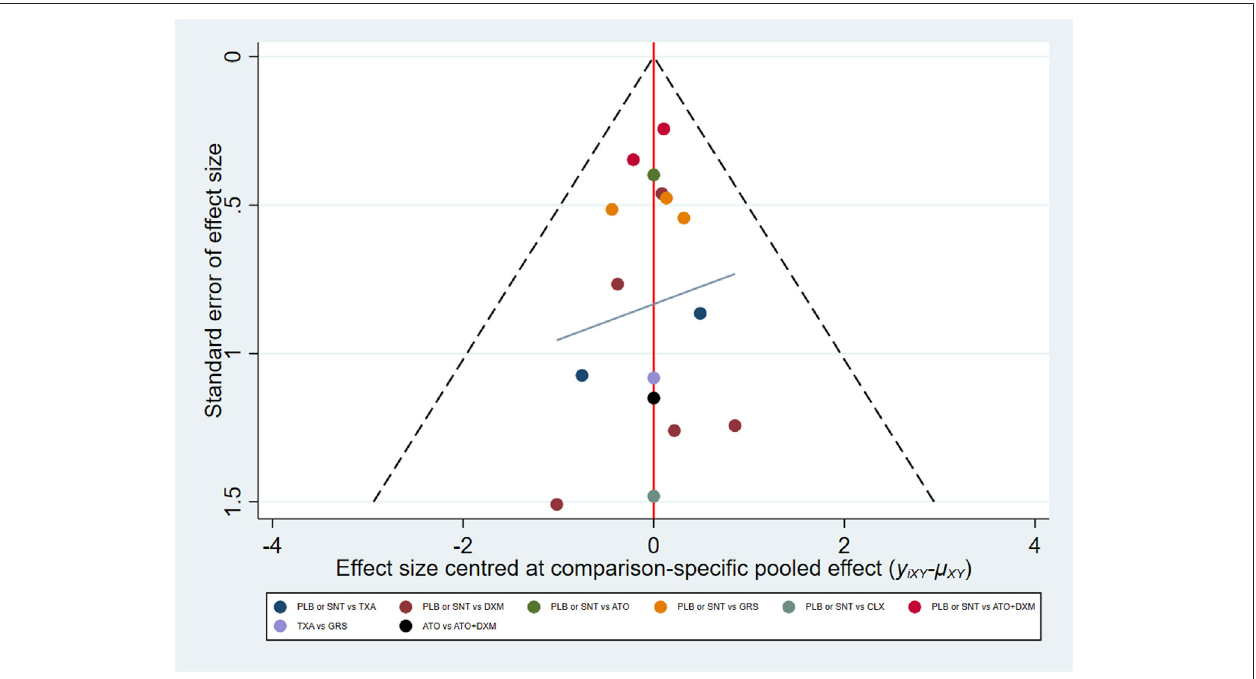
FIGURE 7 | Funnel plot. Red line suggests the null hypothesis that study-speci fi c effect sizes do not differ from respective comparison-speci fi c pooled effect estimates. Different colors represent different comparisons. Abbreviations: TXA, tranexamic acid; DXM, dexamethasone; ATO, atorvastatin; GRS, goreisan; CLX, celecoxib; ATO+DXM, atorvastatin plus dexamethasone; ATB, antithrombotic; PLB or SNT, placebo or standard neurosurgical treatment.